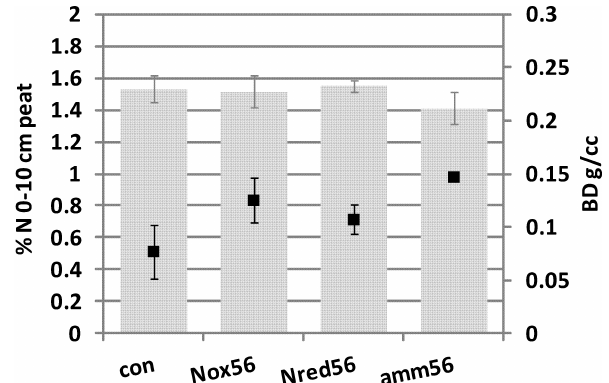
Fig. 5. Percentage of N (drywt), bars, ( + / − sterr) in the 0–10cm peat from the control (no added N) and N treated (oxidised (Nox), reduced (Nred) and ammonia (amm)) plots ( ∼ 56kgNha − 1 yr − 1 ) at Whim bog in 2009 (November) and, on the right-hand axis, the bulk density